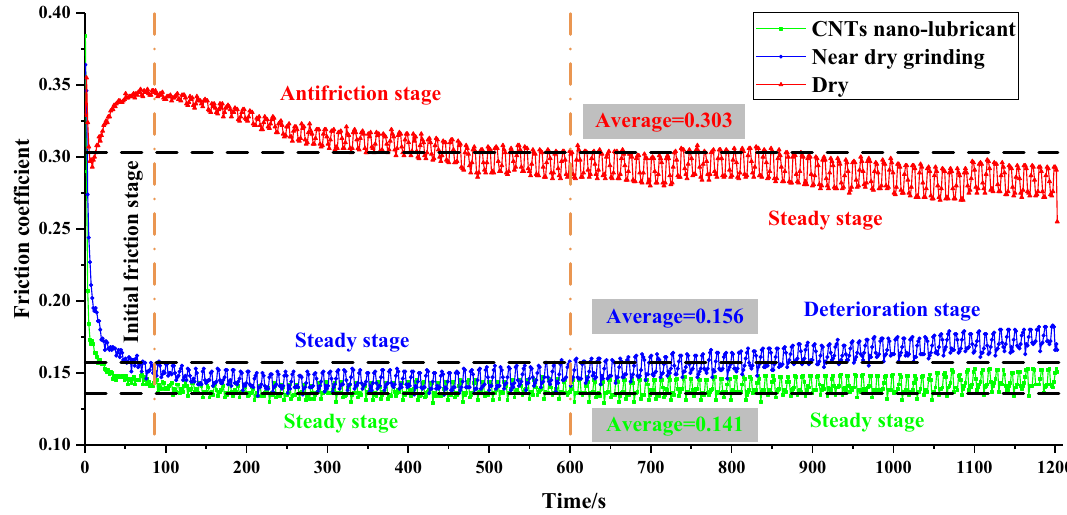
Figure 3. Friction coefficient curve under different lubrication conditions. Figures were created using the Microsoft Visio sofware (version 2010) and Origin (version